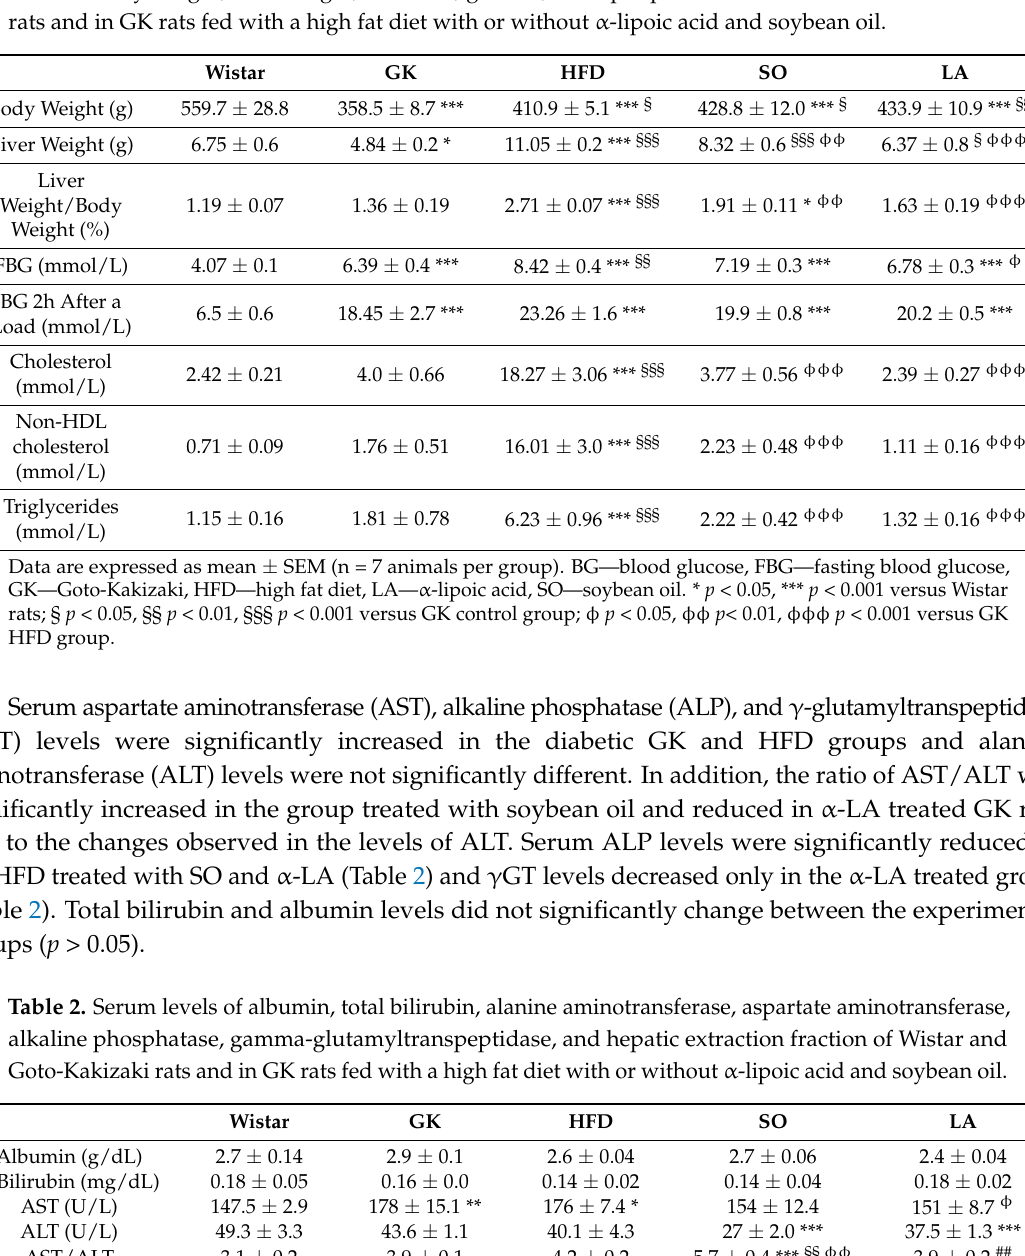
Table 1. Body weight, liver weight, and ratio, glucose, and lipid profile in Wistar and Goto-Kakizaki rats and in GK rats fed with a high fat diet with or without α -lipoic acid and soybean oil. Wistar GK HFD SO LA Body Weight (g) 559.7 ± 28.8 358.5 ± 8.7 *** 410.9 ± 5.1 *** § 428.8 ± 12.0 *** § 433.9 ± 10.9 *** §§ Liver Weight (g) 6.75 ± 0.6 4.84 ± 0.2 * 11.05 ± 0.2 *** §§§ 8.32 ± 0.6 §§§ φφ 6.37 ± 0.8 § φφφ Liver Weight/Body 1.19 ± 0.07 1.36 ± 0.19 2.71 ± 0.07 *** §§§ 1.91 ± 0.11 * φφ Weight (%) FBG (mmol/L)